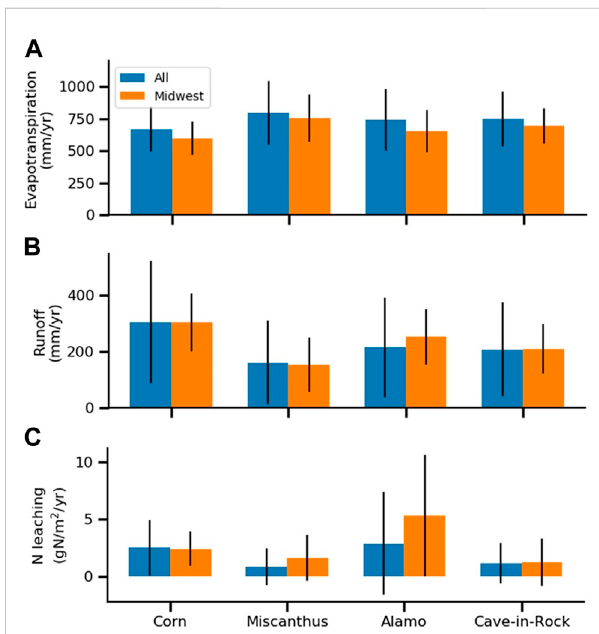
FIGURE 5 The 1980 – 2019 averages for (A) evapotranspiration, (B) runoff, and (C) N leaching for corn (grain plus 30% of stover harvested), and three bioenergy crops, Miscanthus, Alamo, and Cave-in-Rock. The values are plotted for the Central and Eastern United States (All) and the Midwest U.S. (Midwest). Error bars are one standard deviation (S.D.) of all grid cell values of all and Midwest regions.